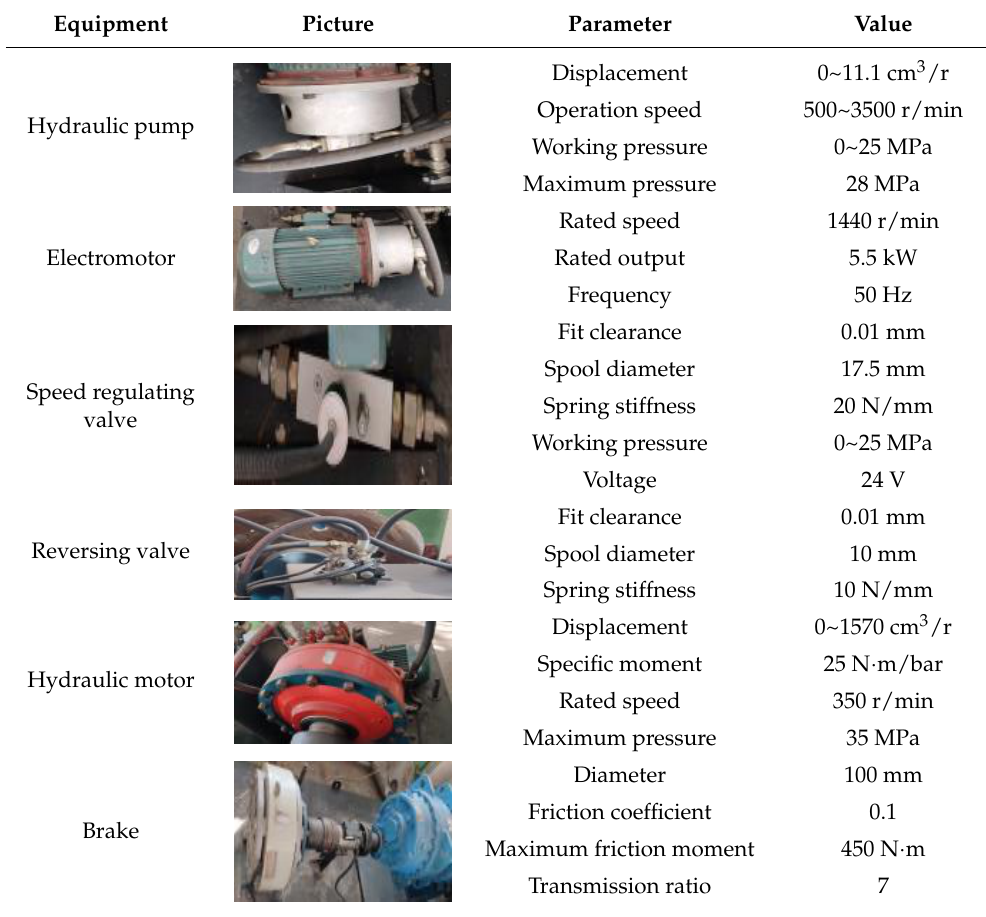
Figure 6. Sail slewing hydraulic testbed.